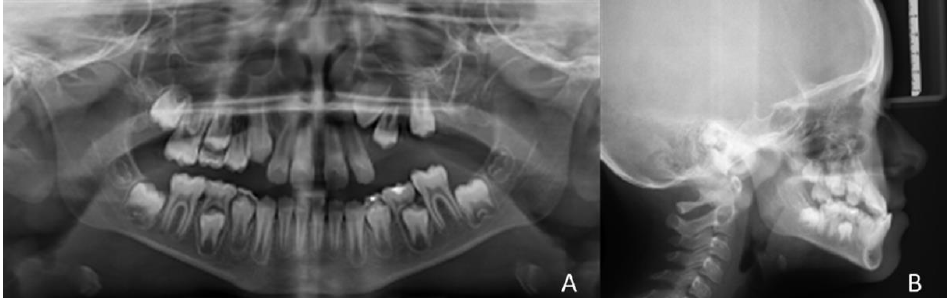
Figure 4. The initial orthopanoramic ( A ) and lateral cephalogram ( B ). The CBCT evaluation of the degree of ossification (Figure 5) of the middle palatal suture showed a well-presented sutural line along its entire length at high density with no or little interdigitation (Stage A) [9].